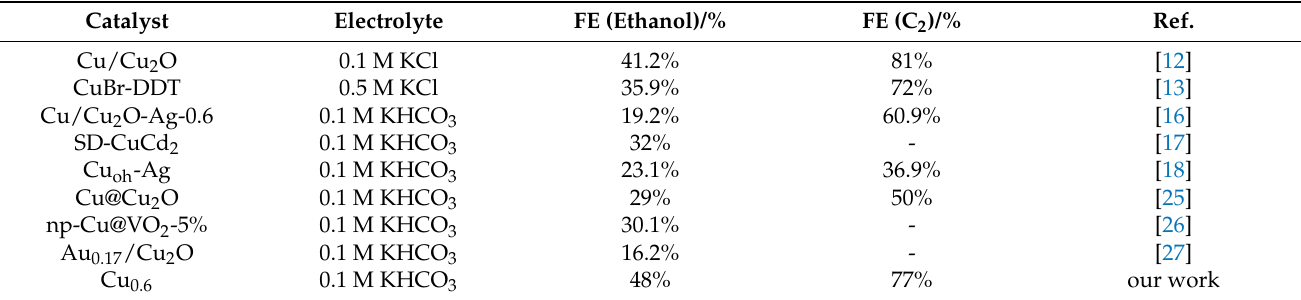
Figure 8. FEs of CO 2 RR products for the ( a ) Cu 0 , ( b ) Cu 0.6 , and ( c ) Cu 1.2 electrodes under different potentials. ( d ) Current stability and FE of ethanol under − 0.6 V vs. RHE potential for 6 h. Table 1. Comparison of ethanol and C 2 FE from recent reports and in our work.